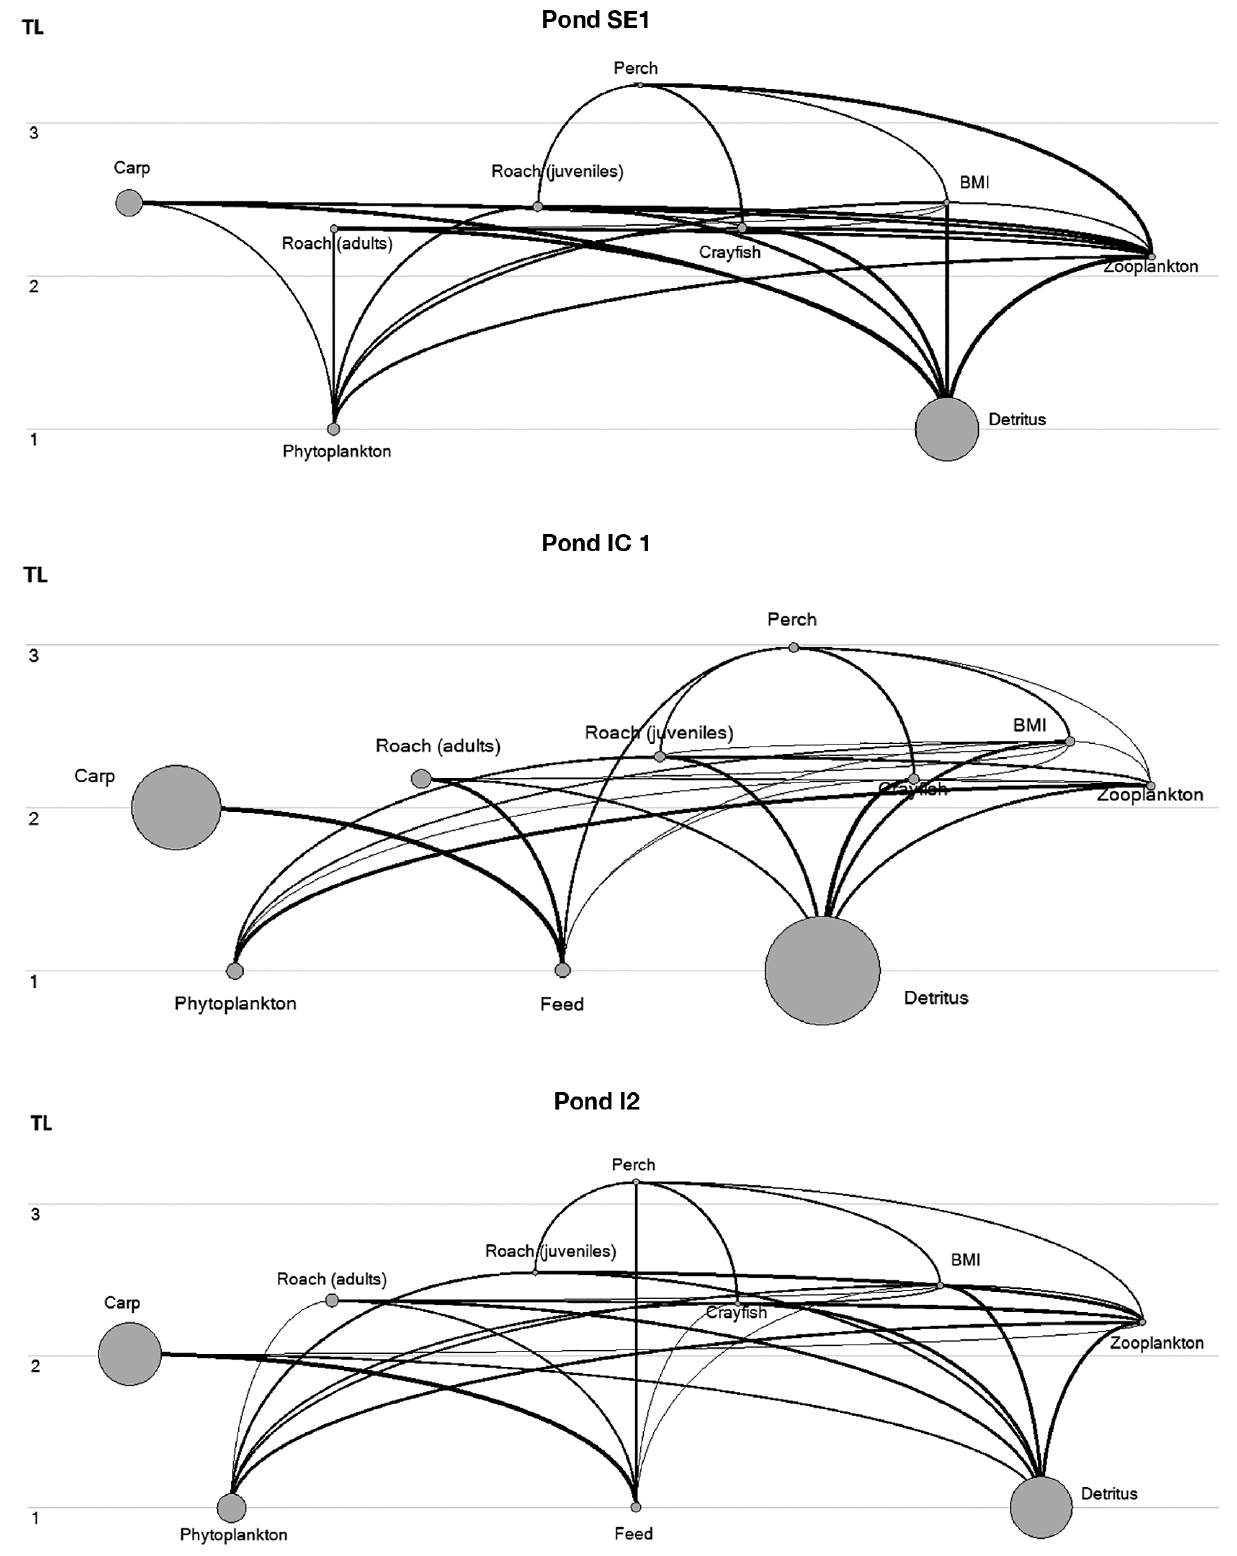
Fig. 2. Flow diagram of the food web as a function of trophic level (TL) in the 3 treatments: Pond SE1: semi-extensive pond no. 1; Pond IC1: intensive pond coupled with a planted lagoon no. 1; Pond I2: intensive pond no. 2. BMI: benthic macroinvertebrates. Circles are proportional to the biomass on a logarithmic